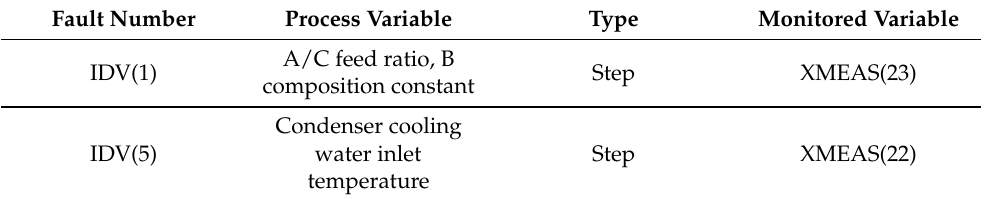
Table 1. Analyzed TEP process faults (see Appendix